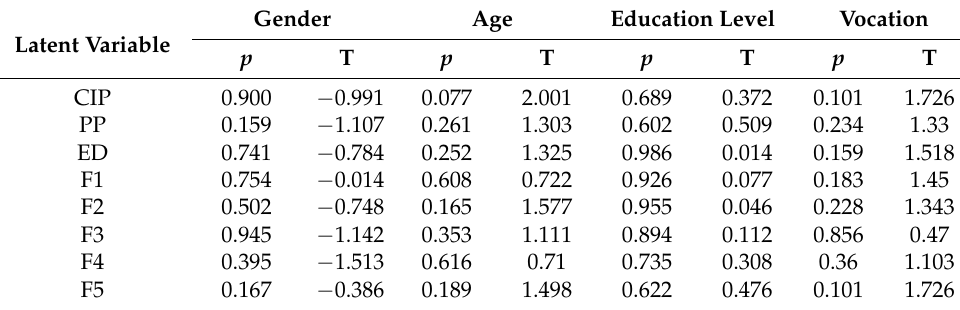
Table 11. Difference in demographic